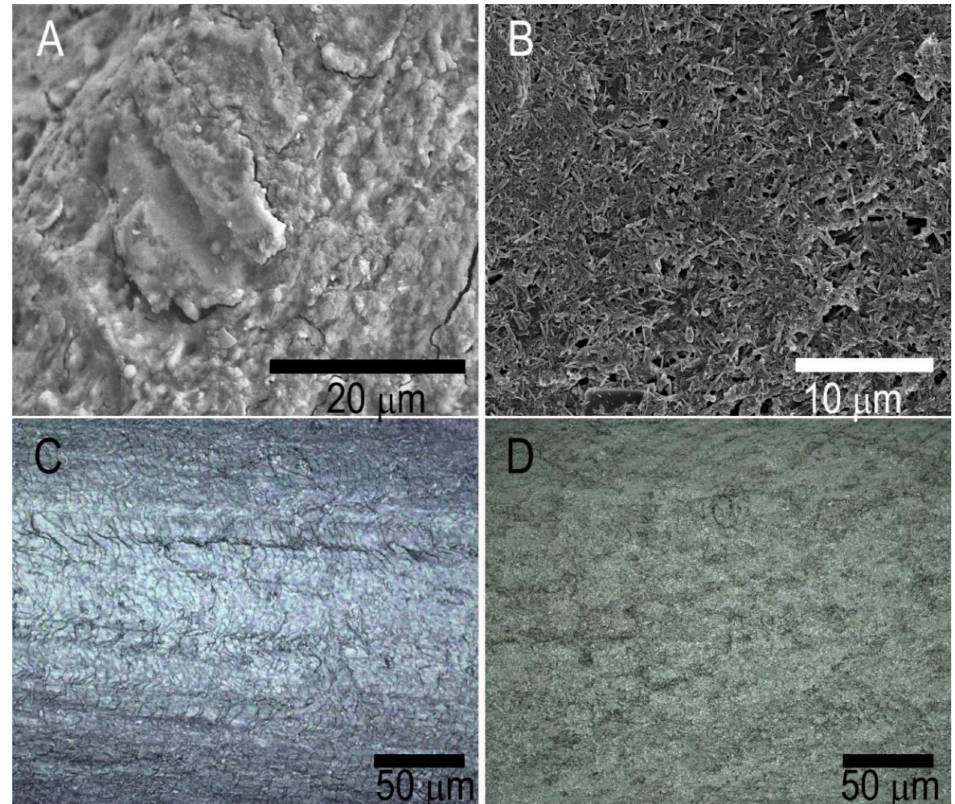
Figure 2. Self-assembly of halloysite clay nanotubes on capybara hair surface: SEM and 3D confocal optical microscopy images of the pristine capybara hair ( A , C ) and the surface is completely covered with HNTs ( B , D